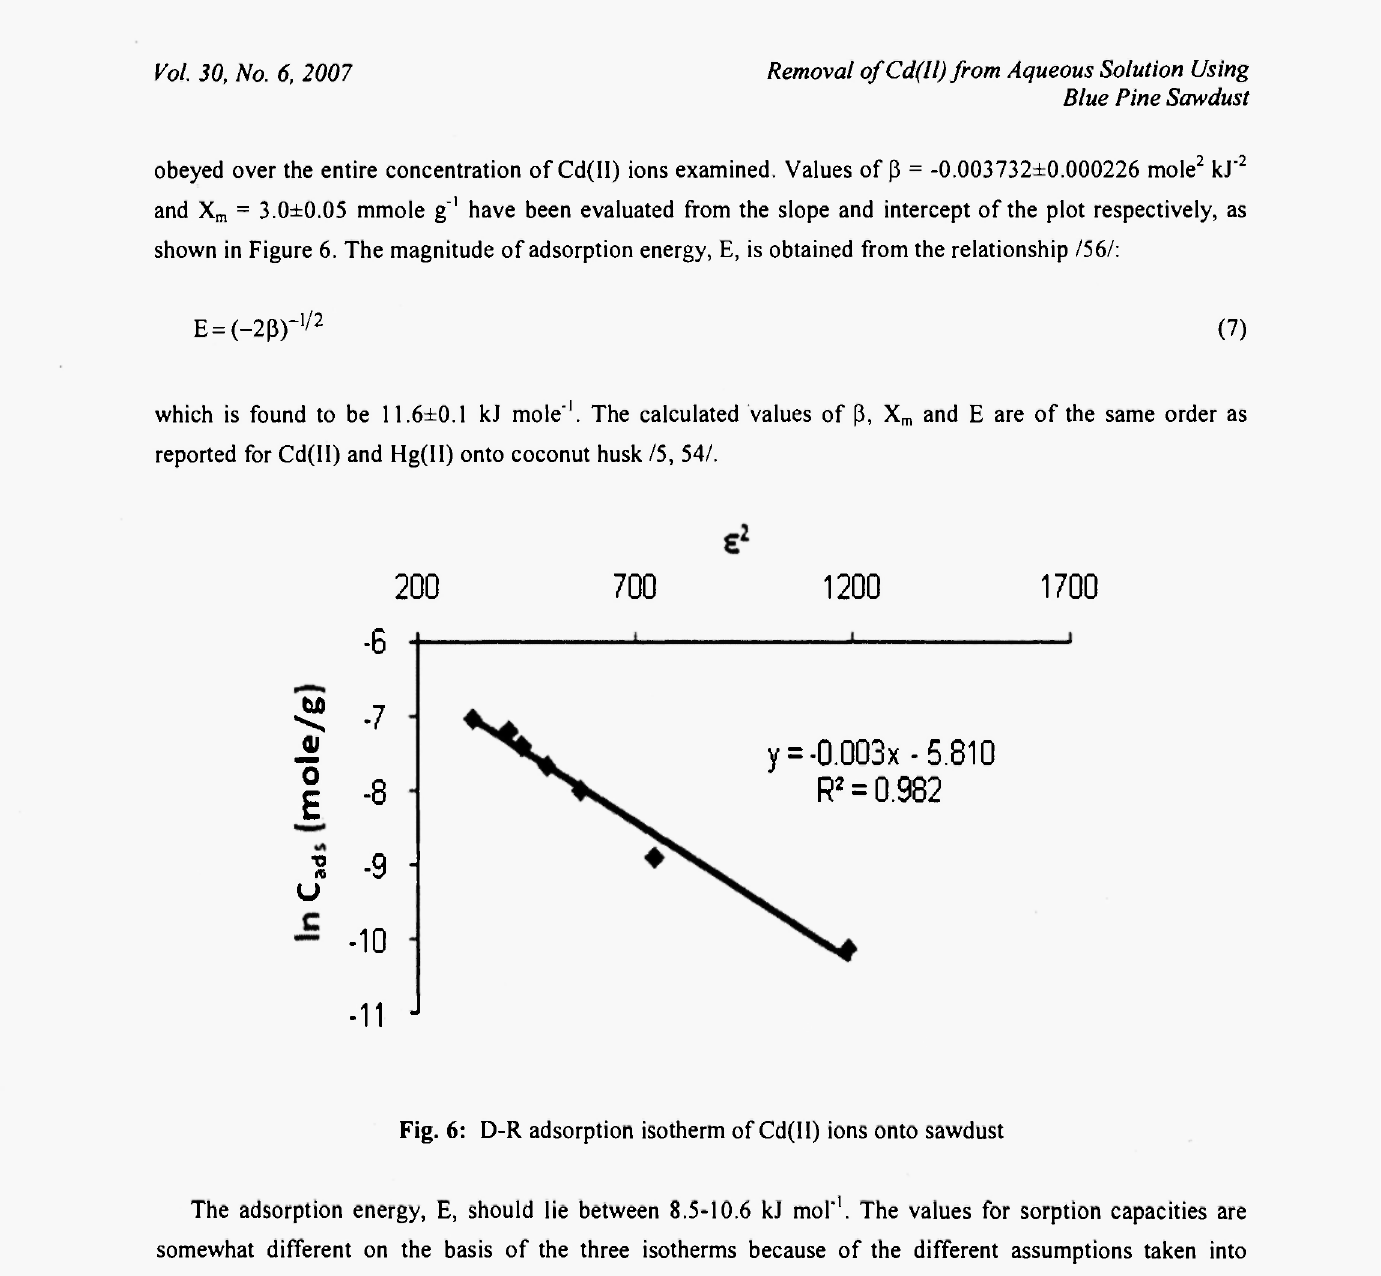
Fig. 6: D-R adsorption isotherm of Cd(II) ions onto